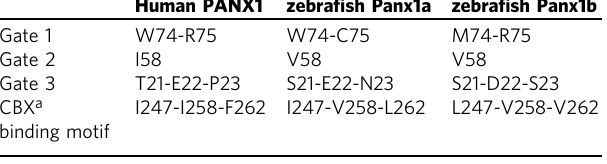
Table 1 A comparison of gates between human PANX1 and zebra fi sh